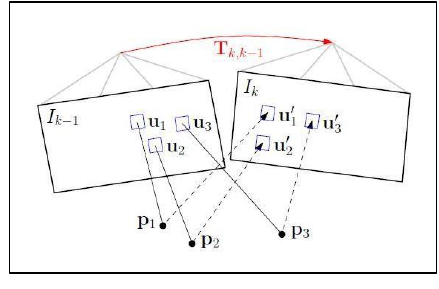
Figure 2. Basic concept of DSO